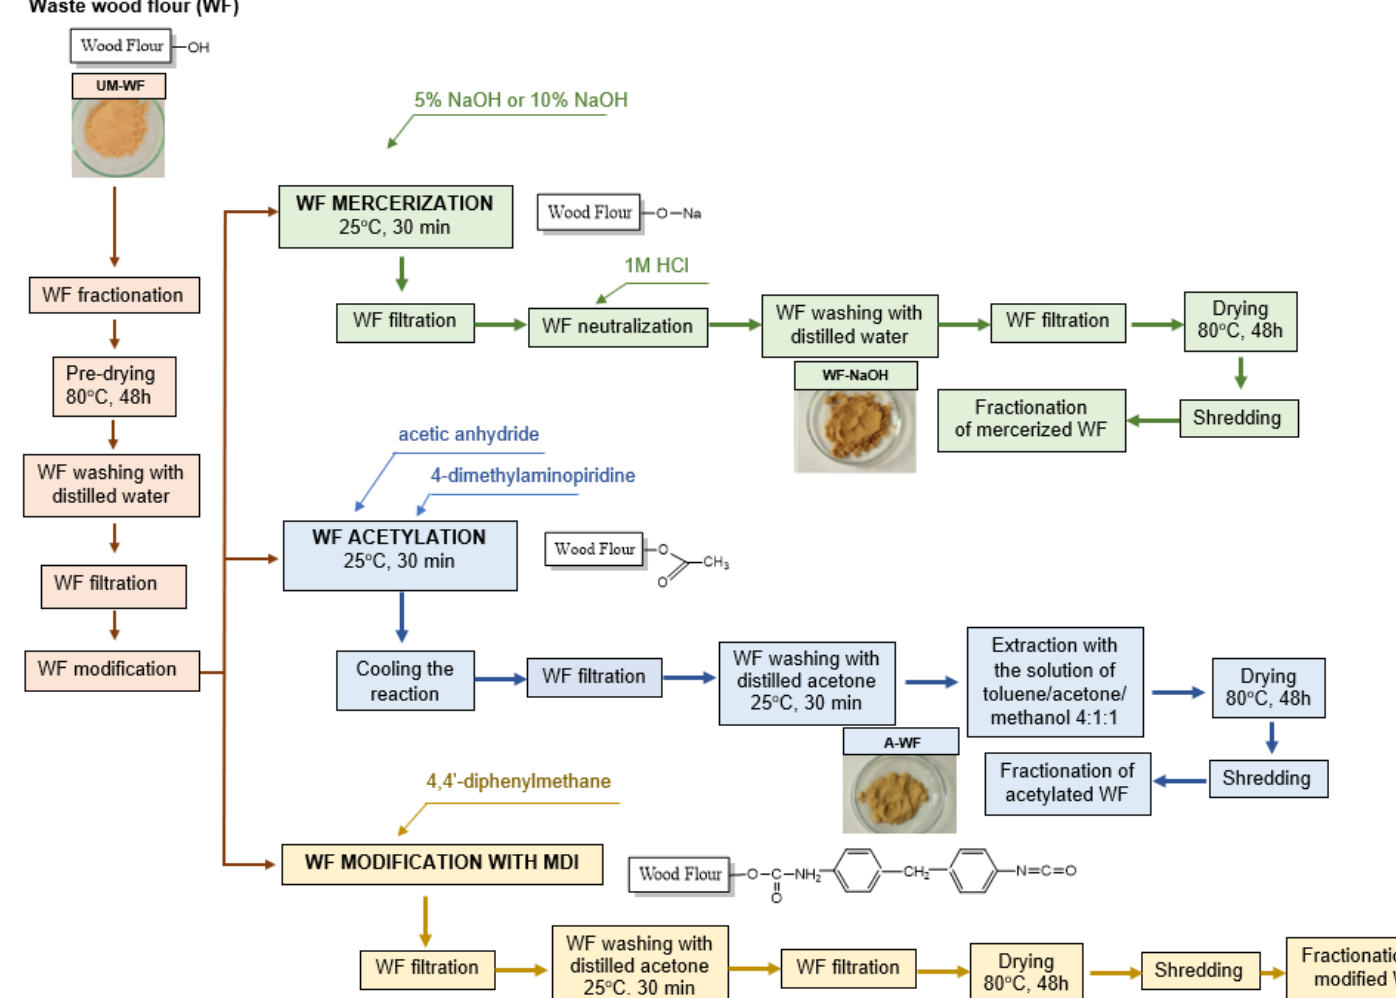
Figure 2. Scheme of the modification of waste oak flour.